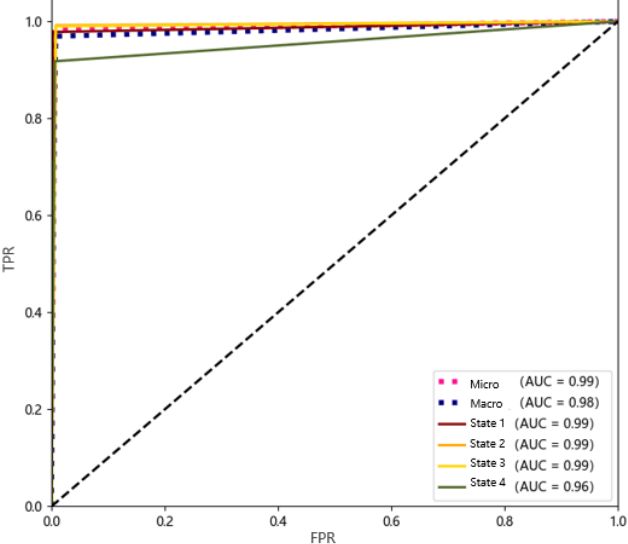
Figure 9. The receiver operating characteristic (ROC) curve of the classifier.